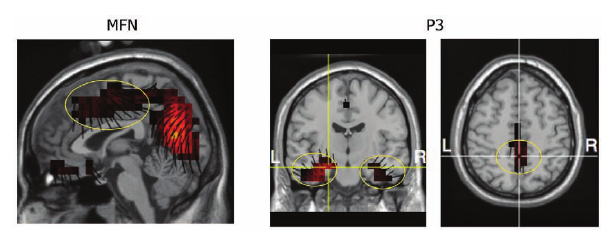
FIGURE 7 | Estimate of source generator for MFN and P3. Lines at each voxel represent orientation vectors (pointing in the positive direction).The vectors indicate the scalp topography features that are accounted by the source voxels (see orientation of these sources relative to the scalp topography of the MFN in Figure 5 and P3 in Figure 6